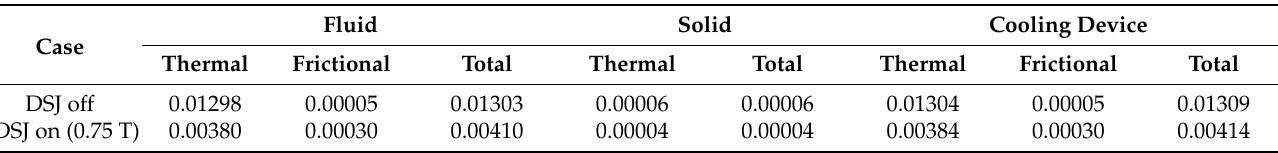
Figure 20. Total entropy generation rate in the fluid domain ( x = 28.5 mm, 0.75 T of DSJ on). Table 2. Thermal entropy generation, frictional entropy generation, and total entropy generation in different areas of the cooling device.